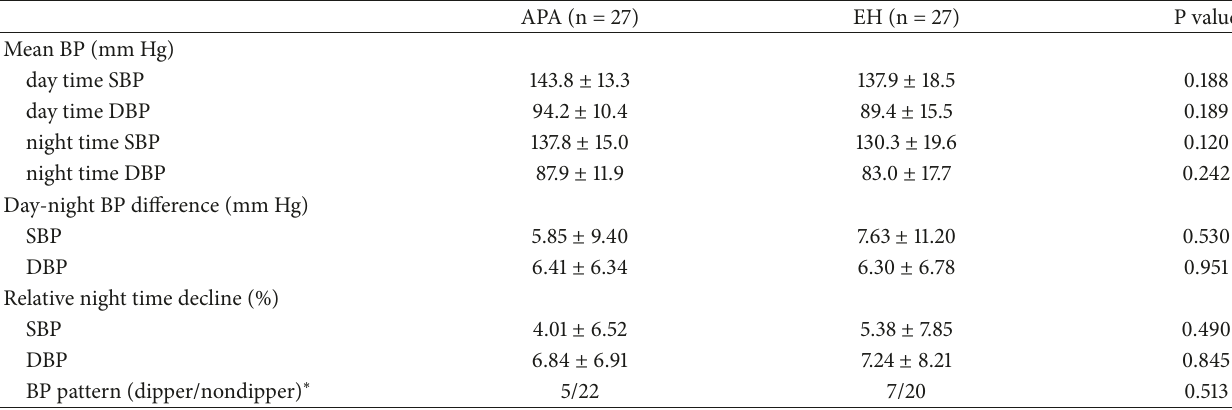
Table 2: Comparison of blood pressure measurements between patients with aldosterone-producing adenoma and essential hypertension. APA (n =